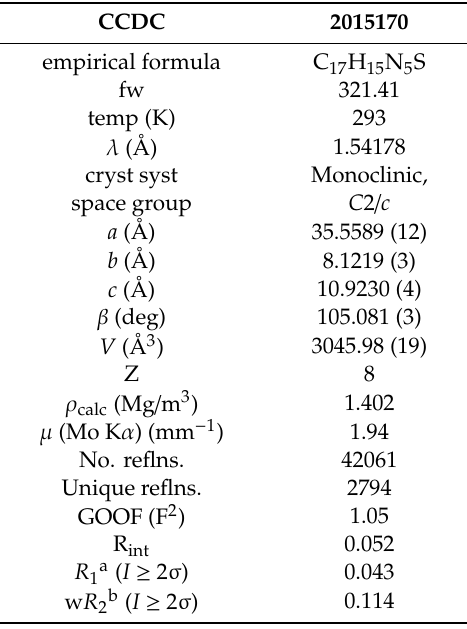
Table 1. Crystal and refinements data of 2 .